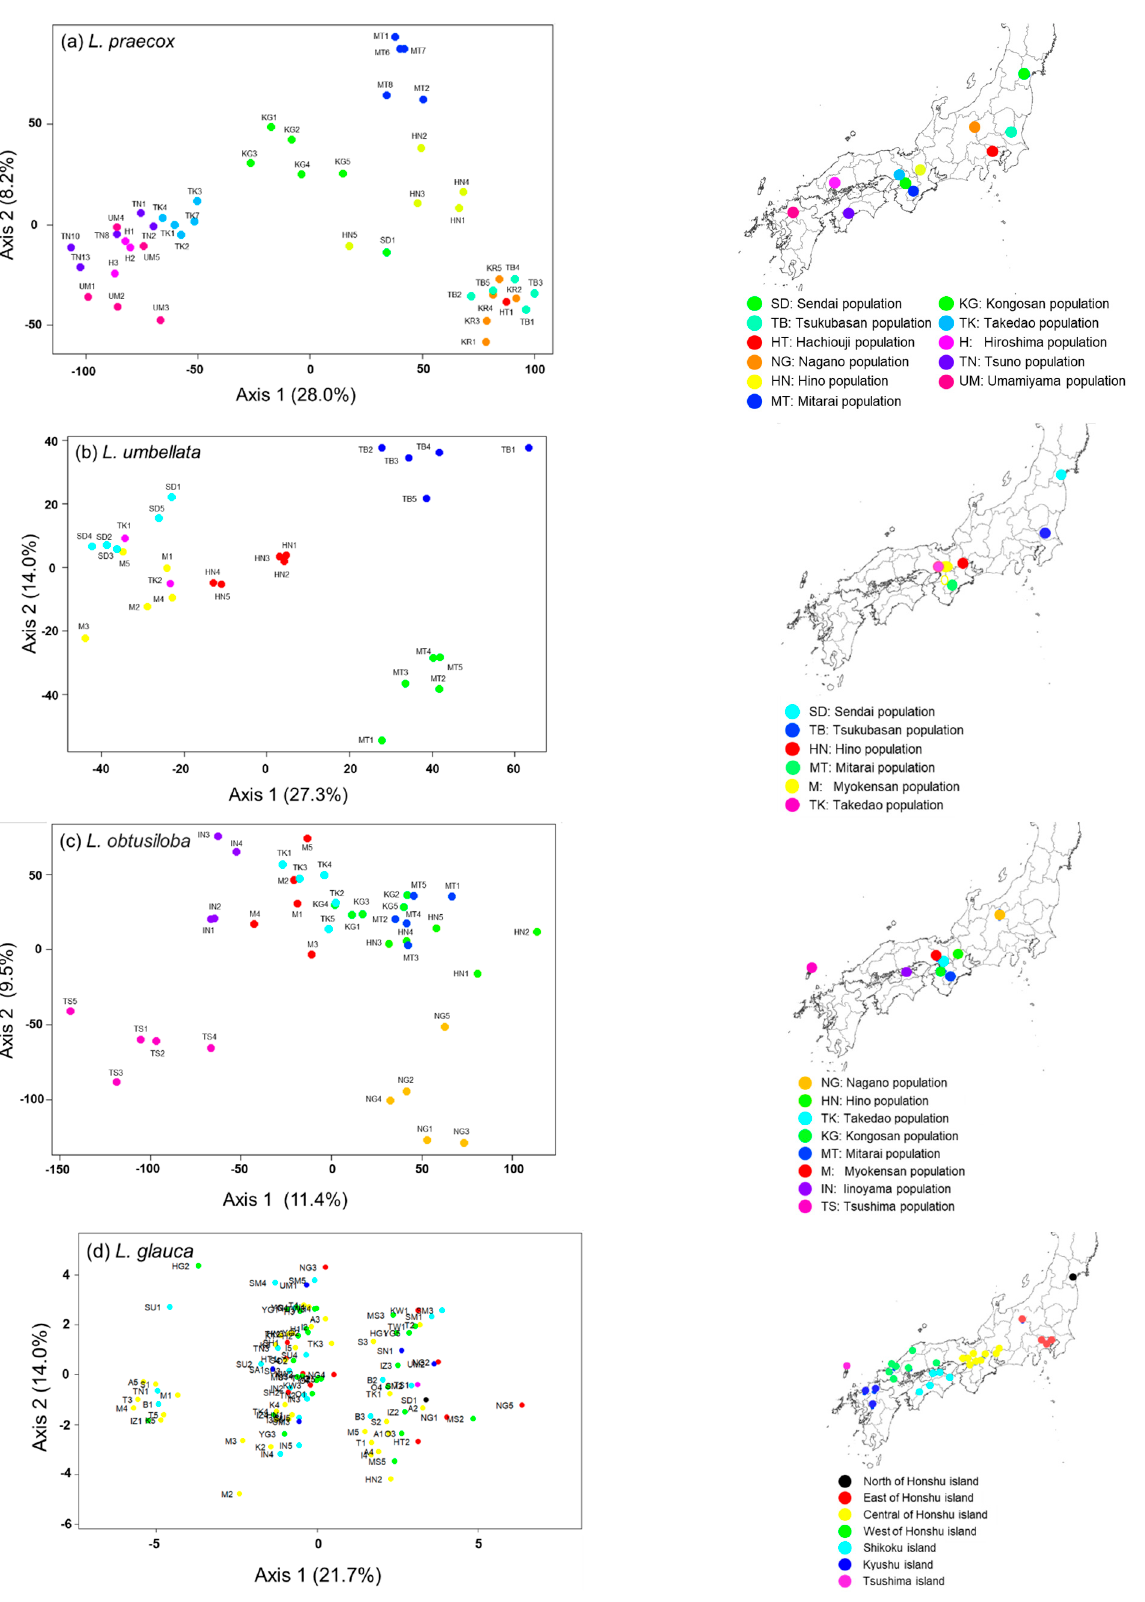
Figure 2. Mantel test for the correlation between F ST and geographic distance among populations of ( a ) L. praecox ( p =